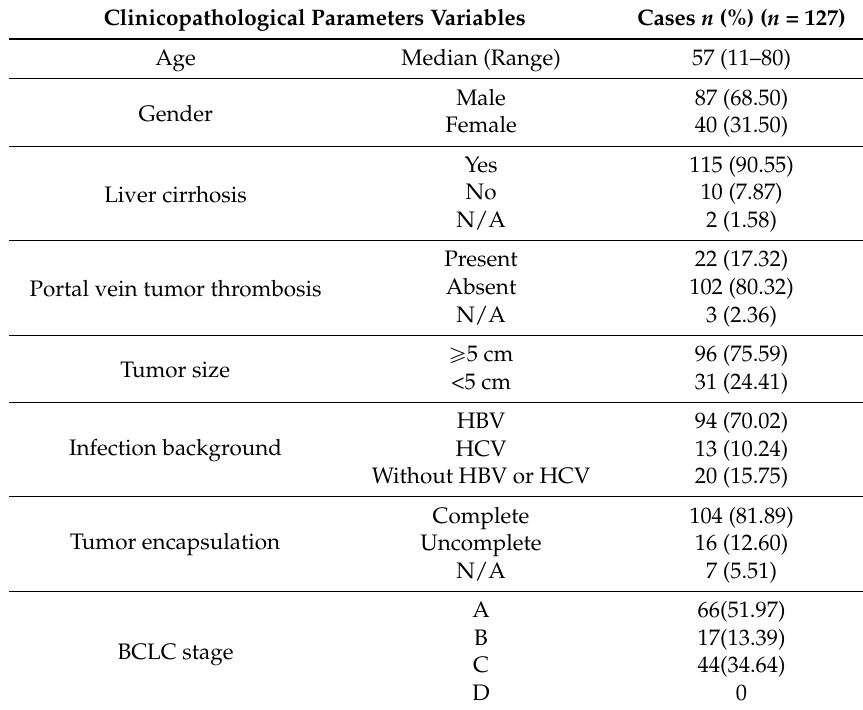
Table 2. Clinicopathological parameters of 127 patients with